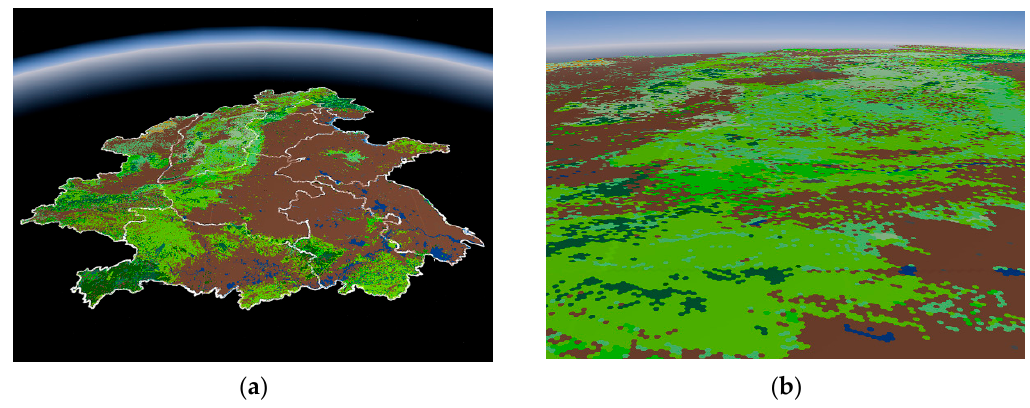
Figure 13. Visualization results for the indexing algorithm proposed in this paper: ( a ) global viewpoint and ( b ) local viewpoint.